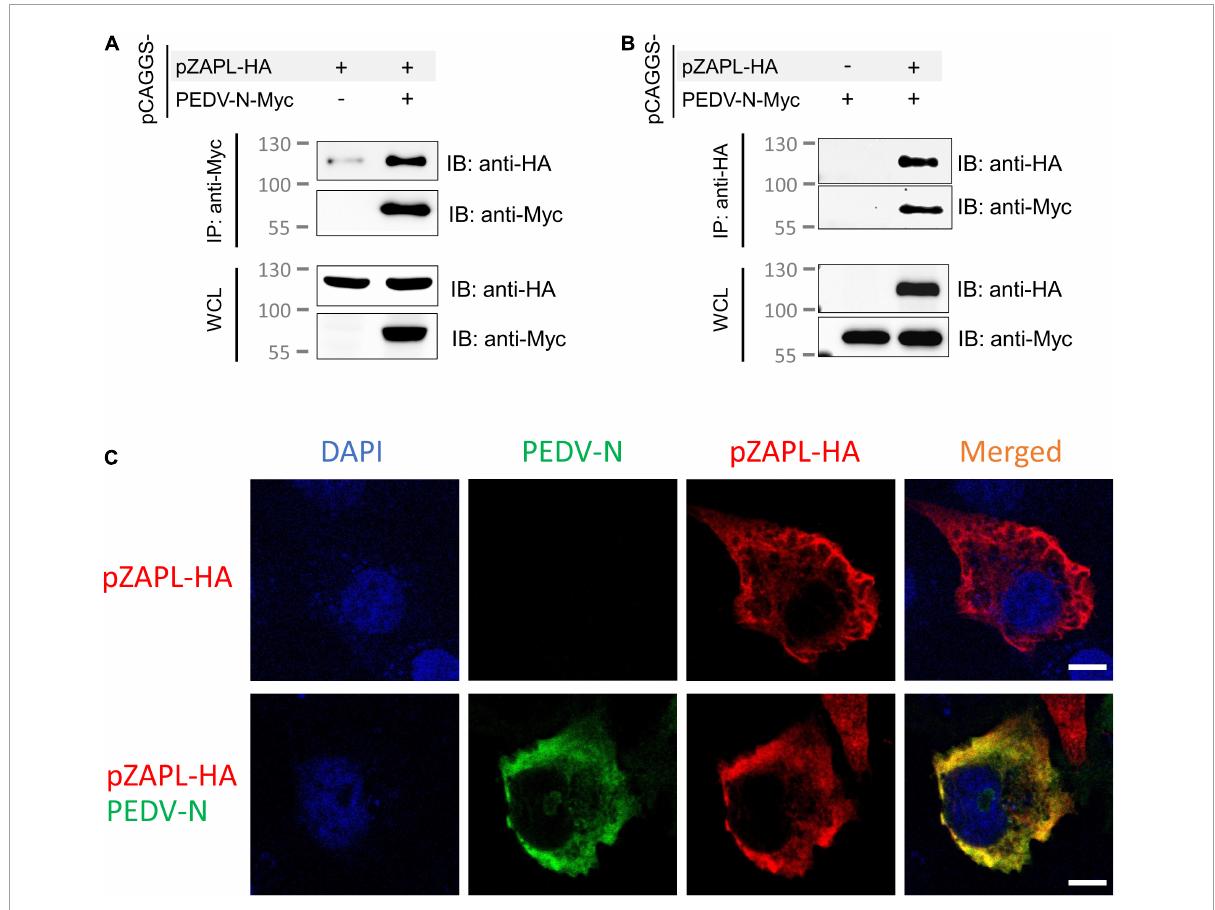
FIGURE5 pZAPL interacts with PEDV-N. (A,B) Cell lysates from ZAP-KO HEK293T transfected with pCAGGS-pZAPL-HA or pCAGGS-PEDV-N-Myc were mixed as indicated. A co-IP experiment was performed with agarose beads conjugated with anti-Myc- (A) or anti-HA (B) antibodies. Prey proteins were analyzed by western blot with the indicated antibodies. (C) Co-localization of PEDV-N with pZAPL. VeroE6 cells were co-transfected with pCAGGS-PEDV-N and pCAGGS-pZAPL-HA. Confocal microscopy images of the transfected cells were taken at 48 hpt to examine the localization of the indicated proteins (scale bar = 10 µ